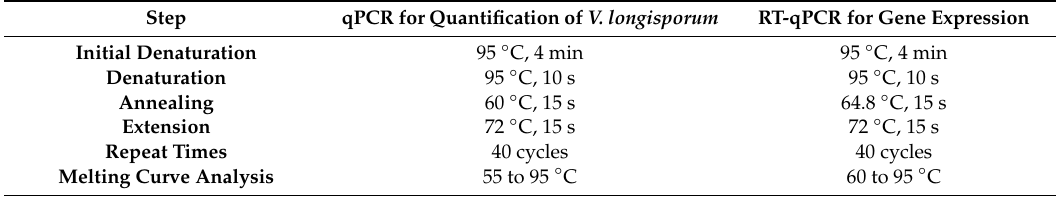
Table 3. PCR program for quantification of DNA of V. longisporum and gene expression